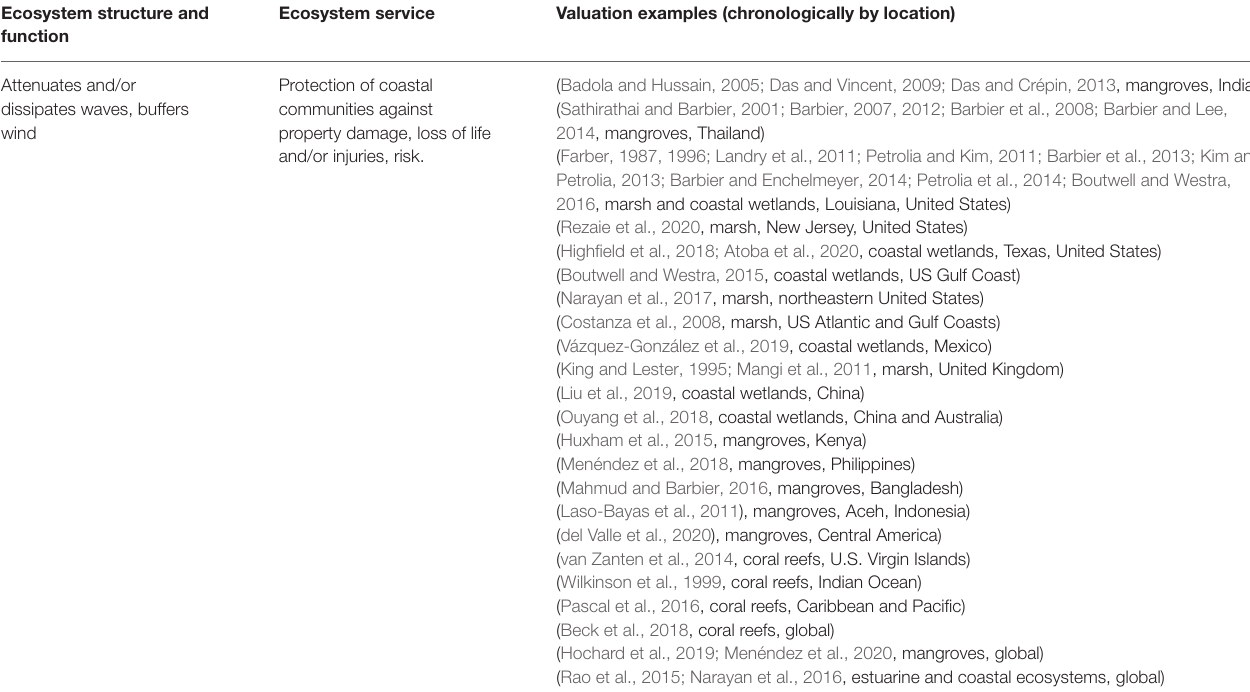
TABLE 1 | Examples of studies that estimate the protective value of estuarine and coastal ecosystems. Ecosystem structure and function Attenuates and/or dissipates waves, buffers wind